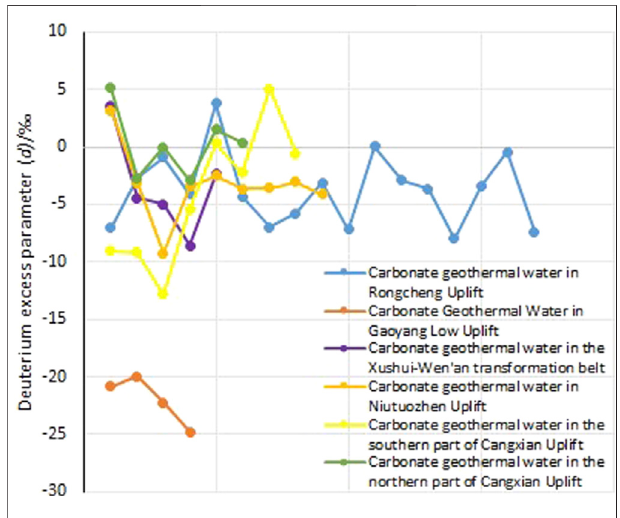
FIGURE 4 | Characteristics of deuterium excess parameter ( d ) in Xiong ’ an New Area and surrounding carbonate geothermal water.